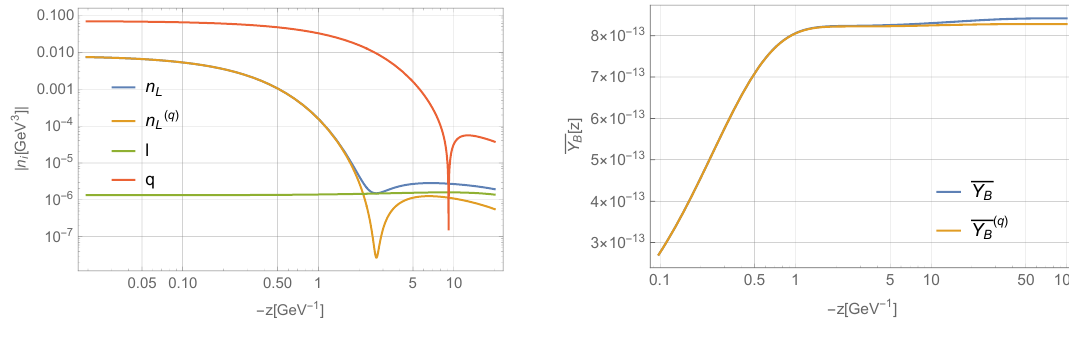
Figure 4 . Left plot: absolute value of the number densities n L , n ( q ) phase for a bottom source. The computation includes top, bottom and tau Yukawa interactions. Right plot: baryon asymmetry (cid:22) Y B ( z ) and (cid:22) Y ( q )